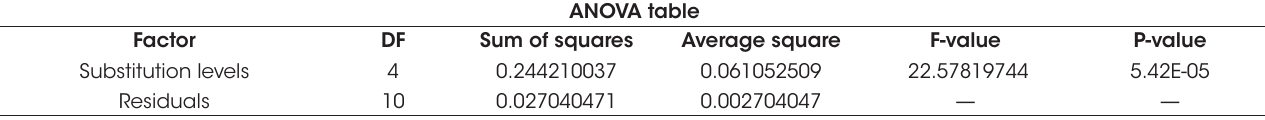
Analysis of variance results – p value – of absorption by